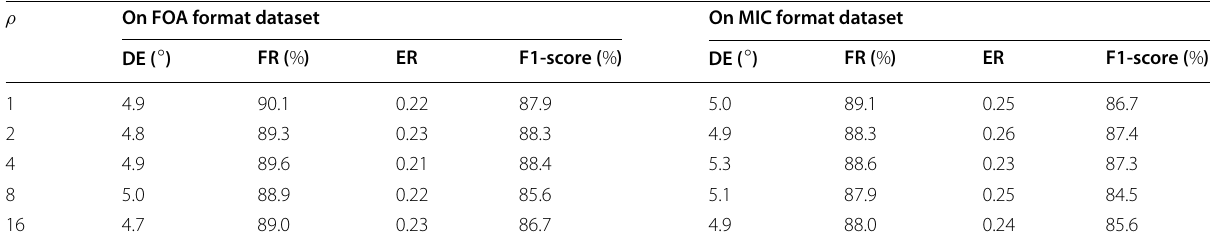
Table 5 Model performance comparison under different attention mechanisms based on FOA and MIC format dataset ρ On FOA format dataset On MIC format